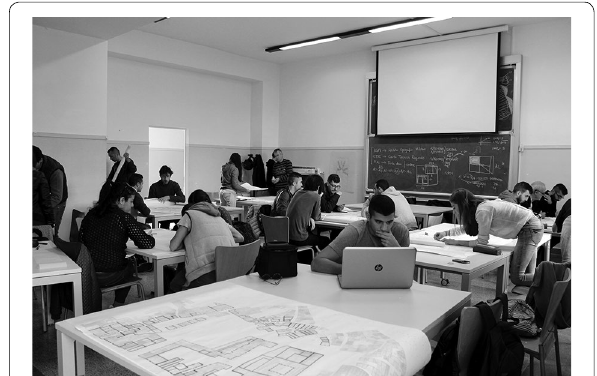
Fig. 2 Site visit to the project areas. Rosello Valley, Sassari. Photo: R. Filippelli